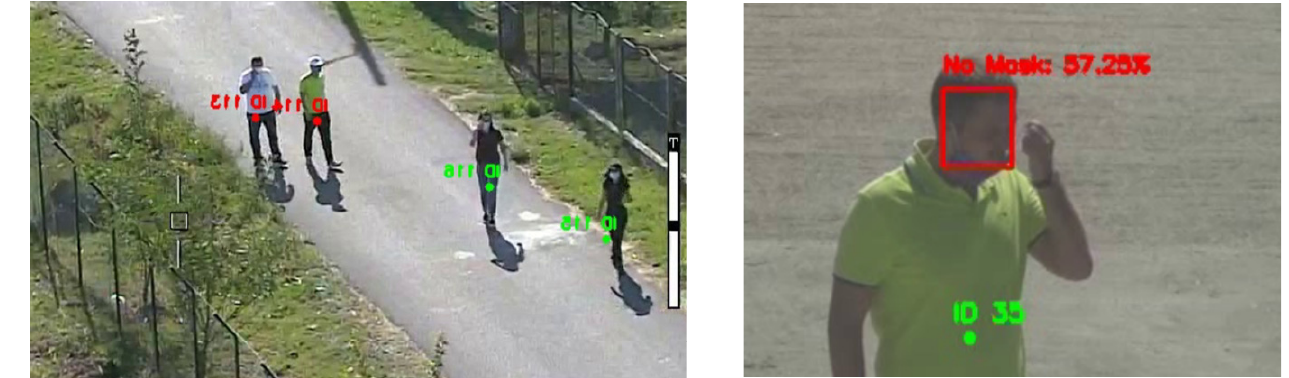
Figure 5. Video recognition (crowd area identification and facial mask presence).